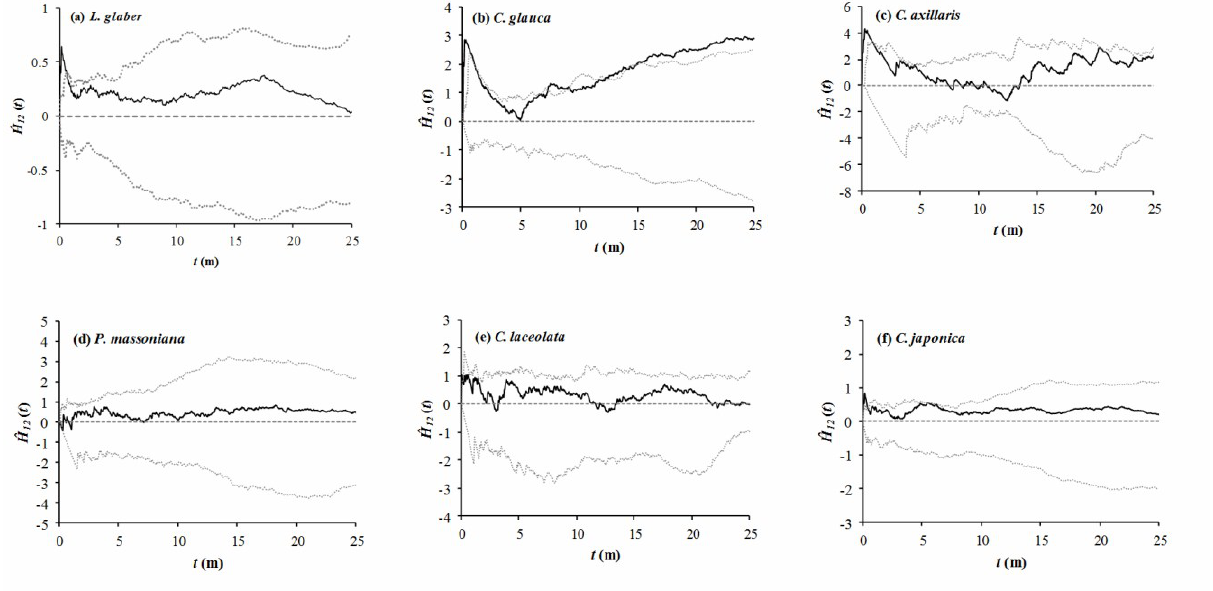
Figure 5. Spatial associations between overstory and understory stems for the six dominant species on the subtropical broadleaved evergreen forest plot on Dashanchong Forest Farm, China. Solid lines represent Ĥ ( t ) values and dashed lines are the upper and lower limits of 12 the 95% confidence envelope of Ĥ ( t ) generated by 999 computations of Monte Carlo (where t is the